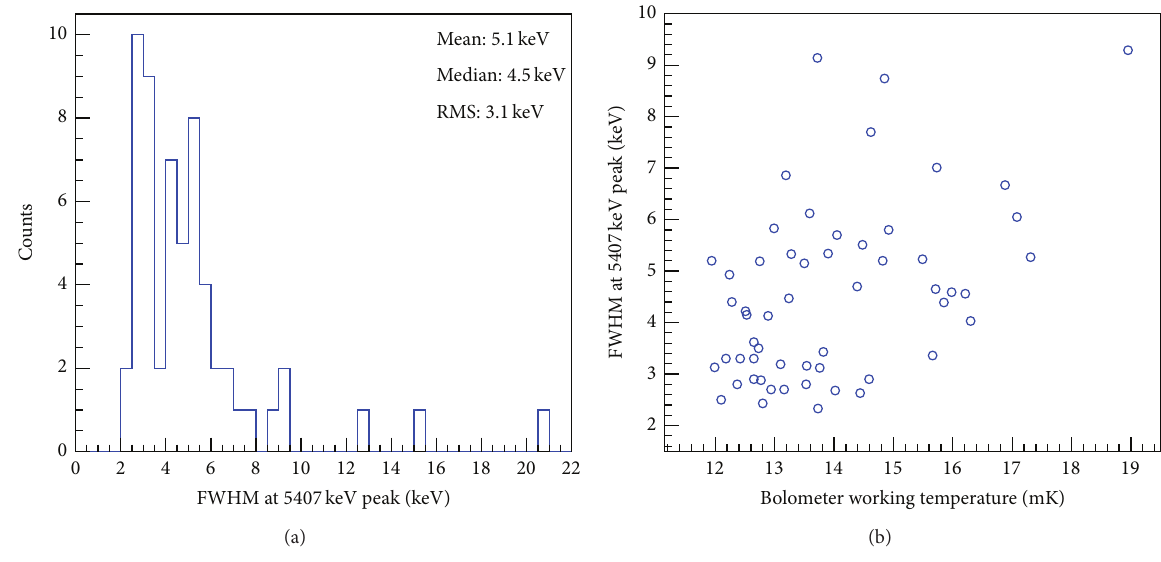
Figure 3: (a) Distribution of energy resolutions at 5407 keV for all CCVR bolometers. (b) Bolometer energy resolution versus detector working temperature for CCVRs